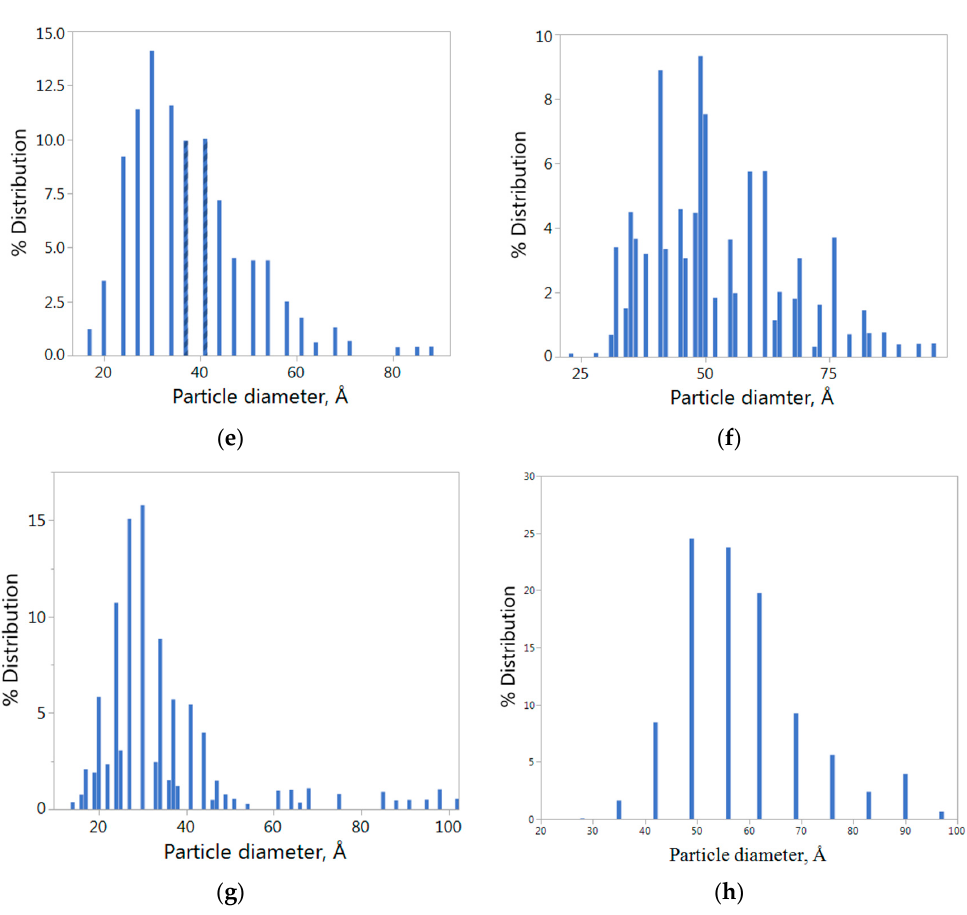
Figure 1. STEM images of ( a ) 5 wt. % Co + 5 wt. % Pd, ( b ) 5 wt. % Co + 2.5 wt. % Pd, ( c ) 5 wt. % Co + 1.25 wt. % Pd, and ( d ) 5 wt. % Co supported on Vulcan XC ‐ 72 carbon black (VXC) prepared by CEDI.